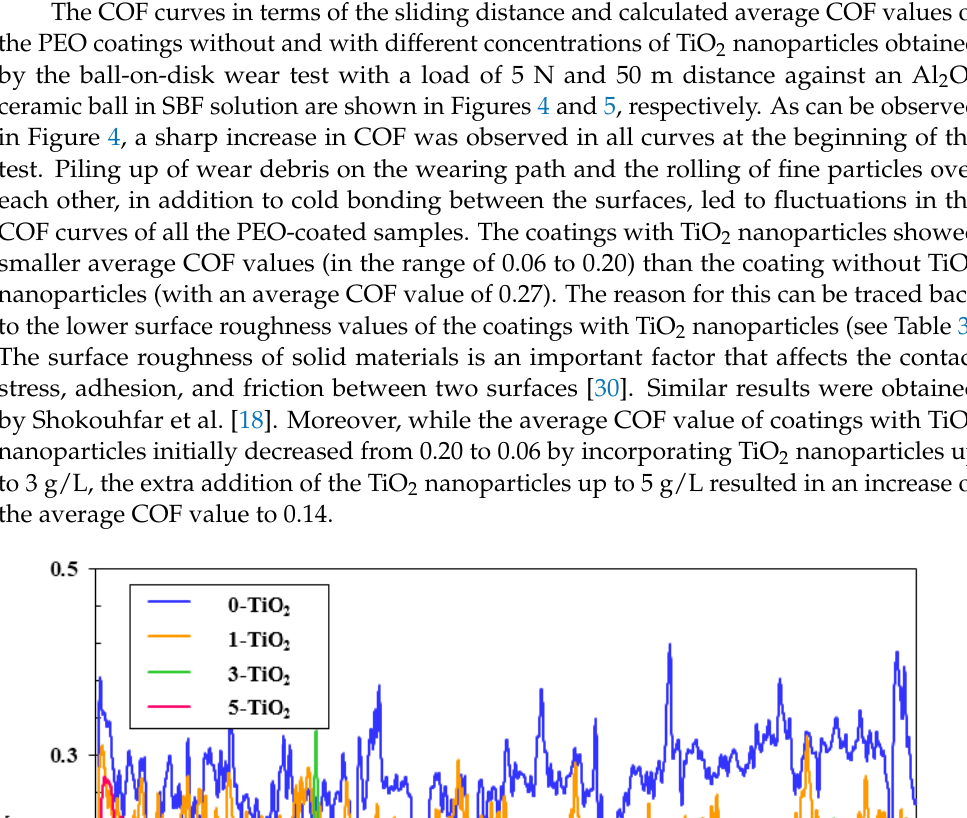
Figure 5. The variations of COF, V, and W values for four different coated specimens. The electron microscopy images from the worn surfaces of the PEO-coated samples are exhibited in Figures 6 and 7. Due to the small thickness and the high brittleness of the PEO ceramic coatings, all coatings appeared to have been completely worn out. The tita- nium substrate under the coatings was plowed after sliding for 50 m. The worn surfaces mainly displayed plowed grooves parallel to the sliding direction with some detached wear debris, indicating a characteristic feature of the abrasive wear mechanism. Accord- ing to the review paper by Guo et al. [31], while the wear behavior under dry friction conditions usually involves adhesive wear and material transfer, the liquid medium to a